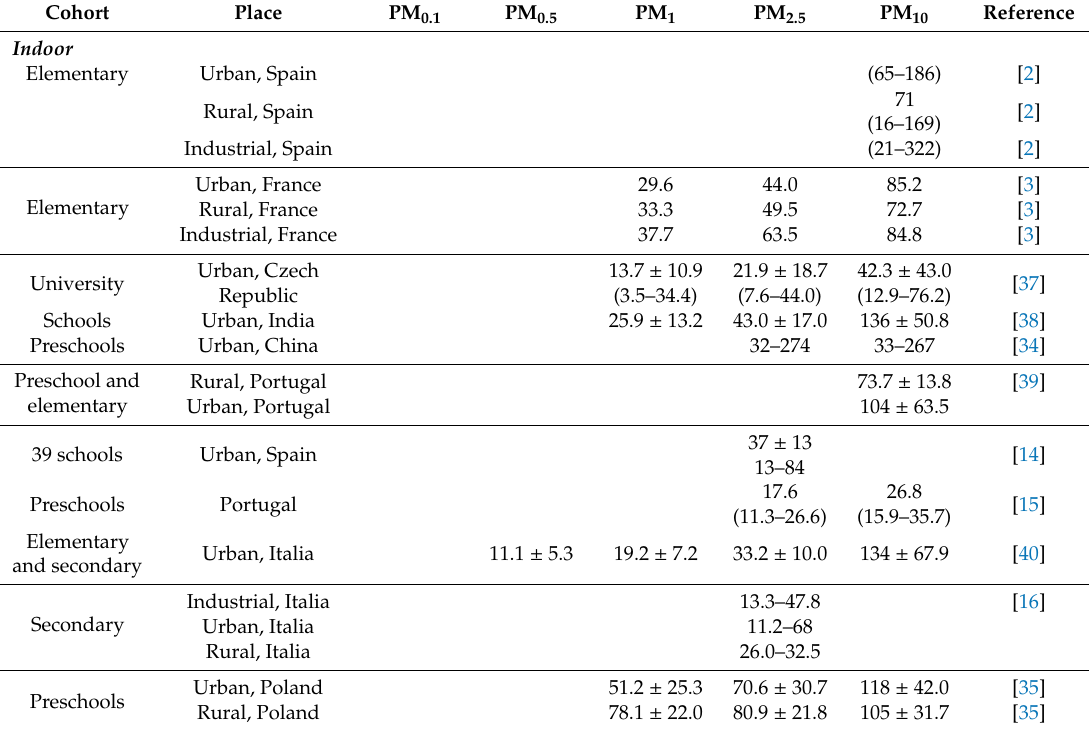
Table 4. Comparison of indoor and outdoor airborne particle concentrations at various schools in the world (in parentheses are min–max